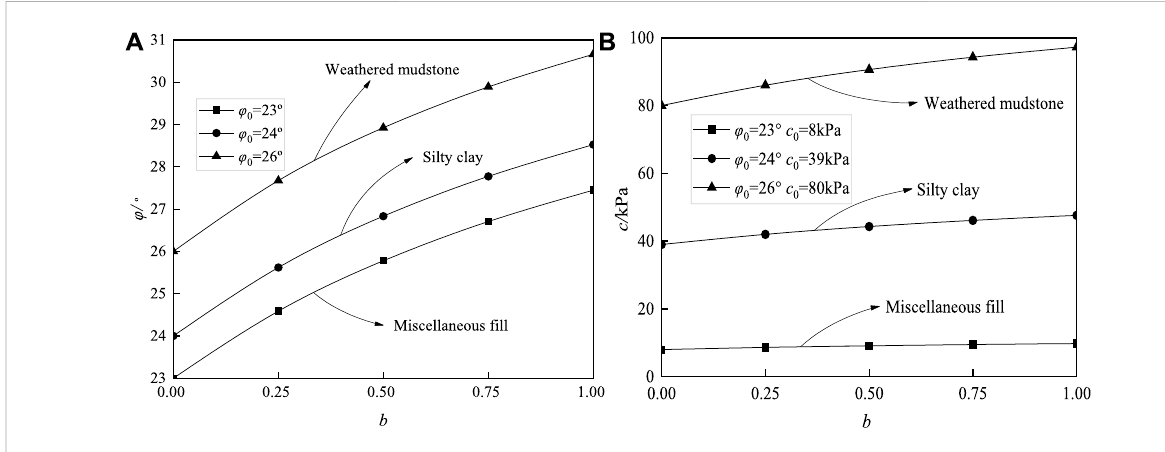
FIGURE 3 In fl uence of parameter b on the shear strength index of soils.